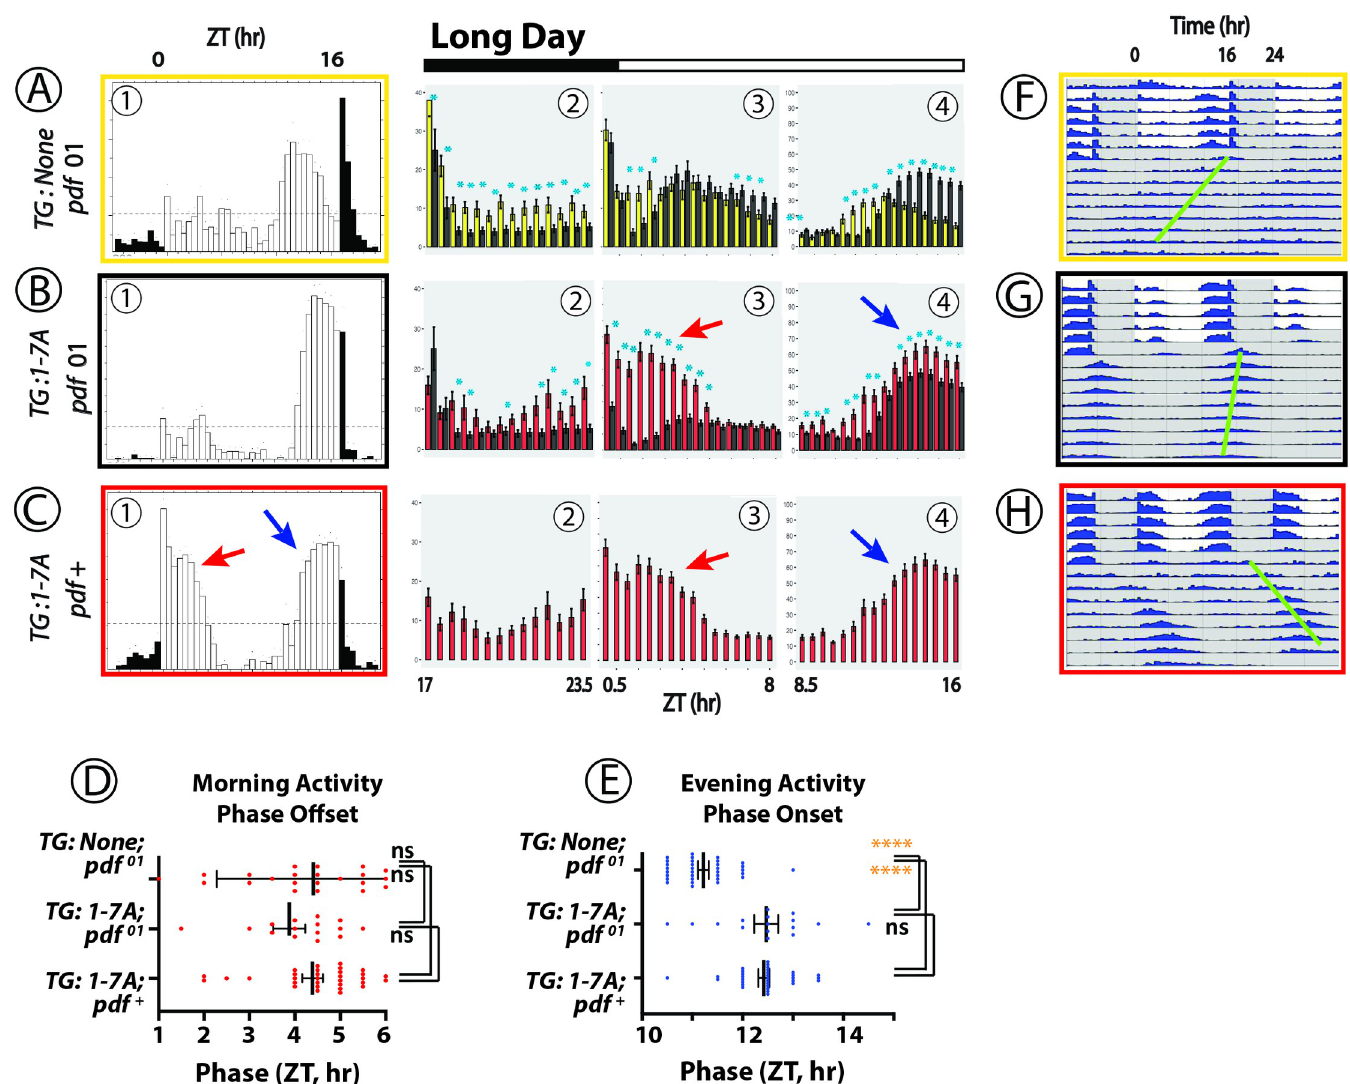
Fig 6. Locomotor Rhythms exhibited by WT versus pdf mutant flies expressing the 1-7A PDFR Variant under Long-day (summer-like) conditions. The Panels present behavioral activity with a format similar to that described in Figure Legend 5. Behavioral records were recorded from pdf 01 (null) flies that expressed either no UAS transgene (A, yellow box), or a UAS-1-7A pdfr transgene (B, black box), or from control flies ( pdf + ) that expressed the UAS-1-7A pdfr (C, red box)). TG : transgene. Panels (A)-(C) display average group eductions (6-day average activity, with open bars indicating the 16-hr periods of Lights-on and filled bars the 8-hr periods of Lights-off) and bin-by-bin analyses to compare activity amplitudes between genotypes. The red and blue arrows indicate Morning and Evening activity of control (red) flies with distinguished amplitude and/or phase, respectively. Blue asterisks mark amplitudes that are significantly different between genotypes by ANOVA followed by a Students t- test (p < 0.05). Panels (D) and (E) display the phases of Morning activity Onsets and Evening activity Offsets respectively. Gold asterisks: ANOVA followed by Dunnett’s post hoc multiple comparisons of all compared to WT: ns = not significant; � = p < 0.05; �� = p < 0.01; ��� = p < 0.005; ���� = p < 0.001. Panels (F)–(H) display double plotted actograms of activity during the ~6 days of light:dark conditions, followed by activity during ~9 days of DD. The green bars indicate the phase of the dominant activity period in DD.